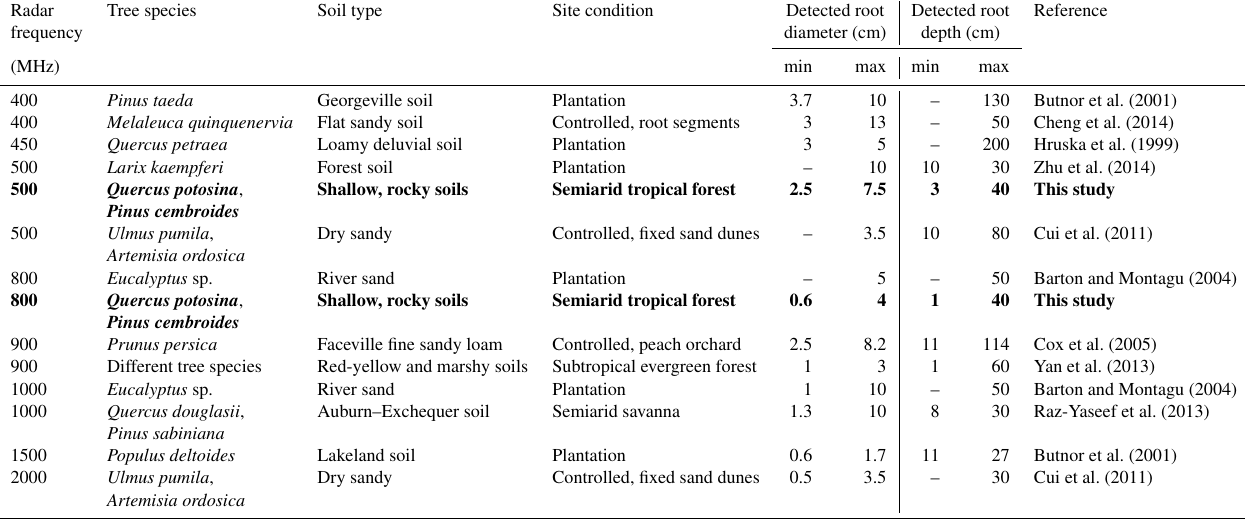
Table 1. A cross-study comparison of the detection capacity (minimum and maximum) of tree root diameter and depth in different soil types using GPR systems with various radar frequencies. Rows in bold refer to GPR conditions used in this study.